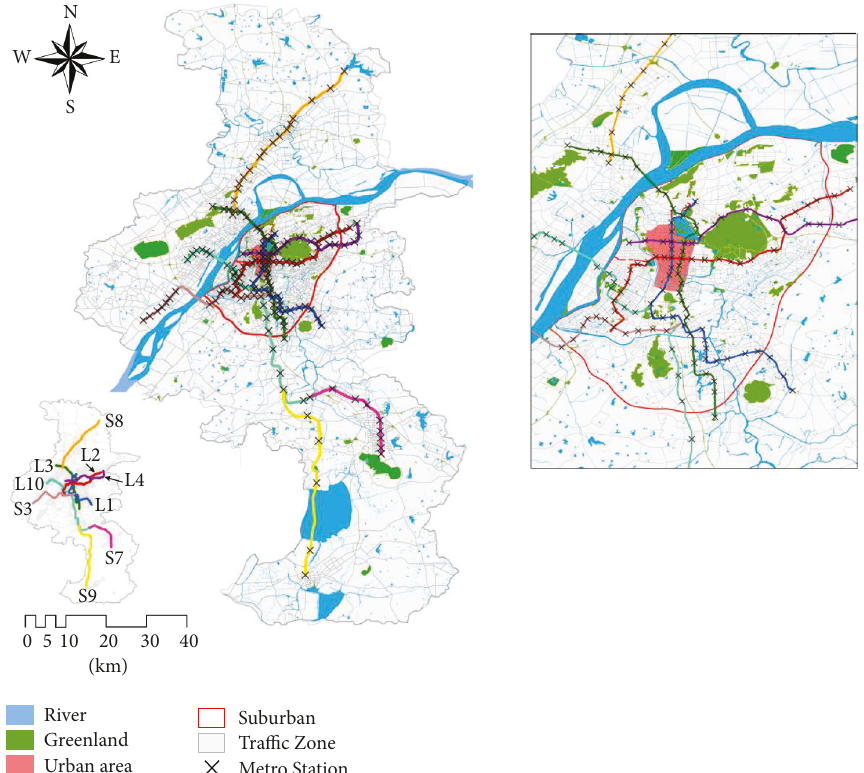
Figure 1: Study area and the existing metro lines in Nanjing,